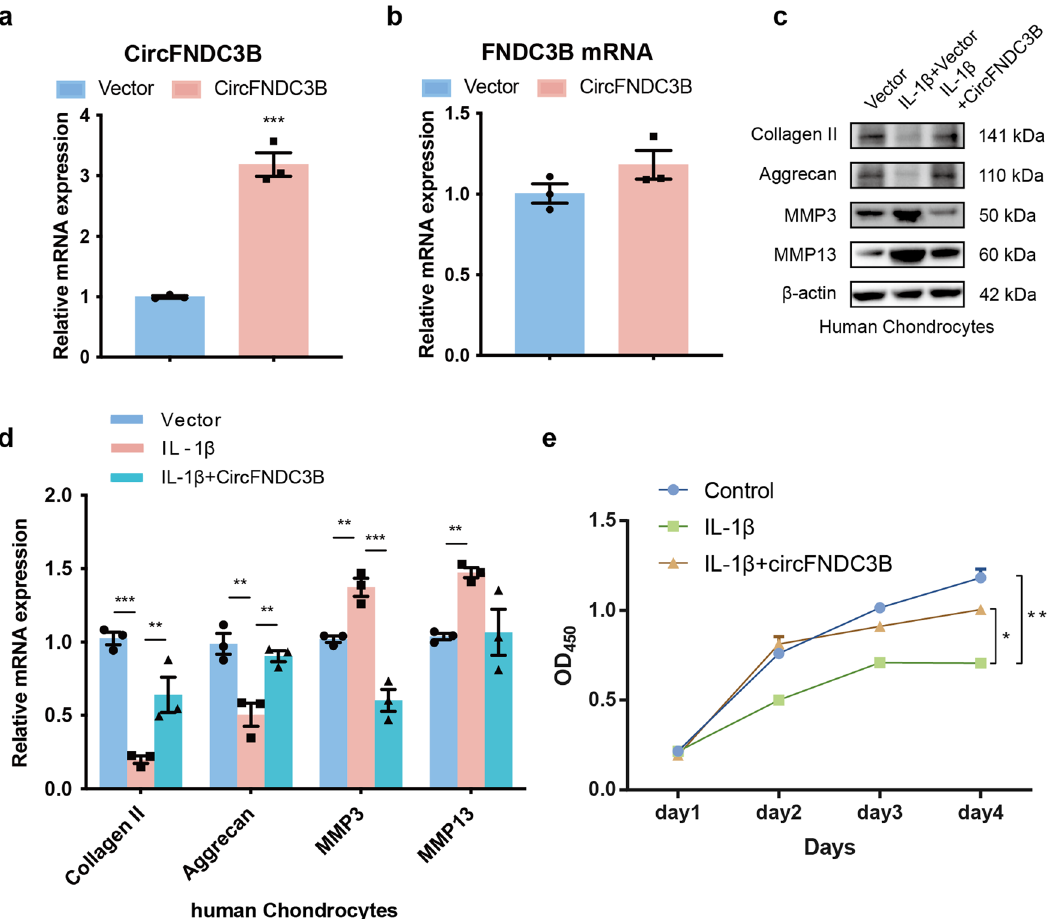
Fig. 3 Overexpression of CircFNDC3B promotes proliferation and ECM metabolism in HCs. a RT-qPCR analysis of the overexpression ef fi ciency of CircFNDC3B in HCs. Vector (empty vector) was used as control. ( n = 3). *** p < 0.001 by Student ’ s t test. b RT-qPCR analysis of the relative level of FNDC3B mRNA in the HCs after overexpression of CircFNDC3B. ( n = 3). c , d Western blot and RT-qPCR analysis of Collagen II, Aggrecan, MMP3, and MMP13 when HCs were treated with IL-1 β and the rescuing effects of overexpressed CircFNDC3B on IL-1 β . β -actin was used as a loading control. ( n = 3). ** p < 0.01, *** p < 0.001 by Student ’ s t test. e HCs viability was detected by the CCK-8 assay. ( n = 3). * p < 0.05, ** p < 0.01 by